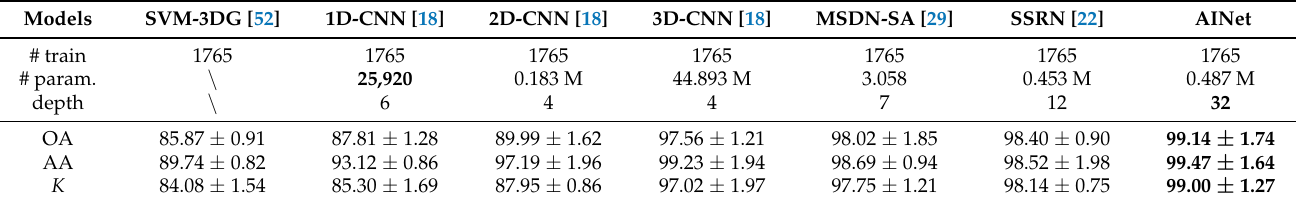
Table 7. Classification results for the Indian Pines dataset.